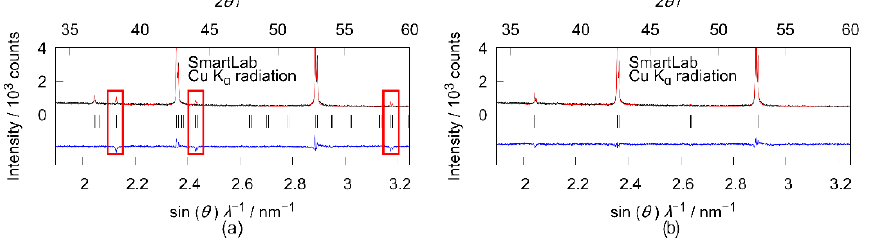
Figure 12. Comparison of the Rietveld refinements of the crystal structure of ( a ) Ba 2 In 1.8 Cr 0.2 O 5 ( I4cm ) and ( b ) BaIn 0.9 Cr 0.1 O 2.5 ( Pm 3 m ) at 1123 K while heating under nitrogen flow of 20 sccm ( p = 0.15 MPa, p (O 2 ) < 5 ppm, p (H 2 O) < 5 ppm) in an XRK reaction chamber at 30° ≤ 2 θ ≤ 60°.